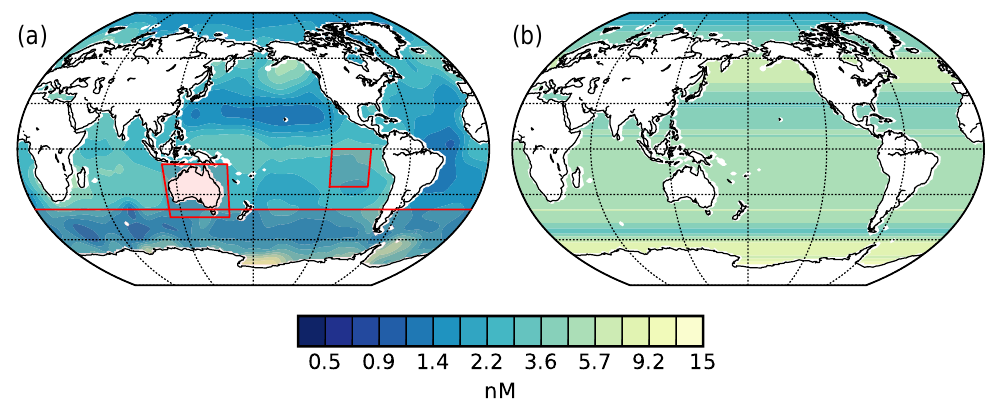
Figure 2. The annual mean concentrations of (a) the Lana et al. (2011) DMS w climatology and (b) the DMS w field of the second experimental run, zonal maximum DMS w . Additionally, three regions of interest are shown in (a) by red boxes: the Australian region, 45–10 ◦ S, 110– 160 ◦ E, the Southern Ocean (SO), ocean grid points south of 40 ◦ S, and the south-eastern Pacific (SEP), 240–270 ◦ E, 25 ◦ S–0 ◦